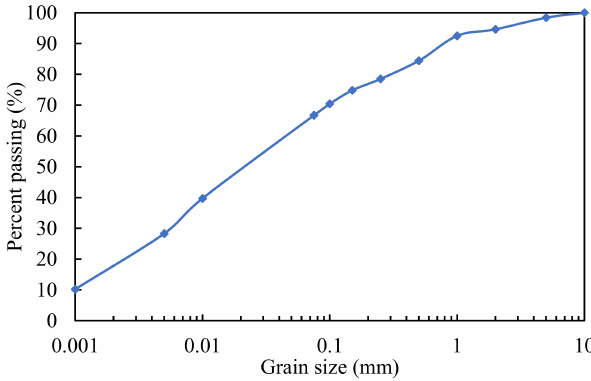
Figure 7. Gradation curve of the excavated soil.